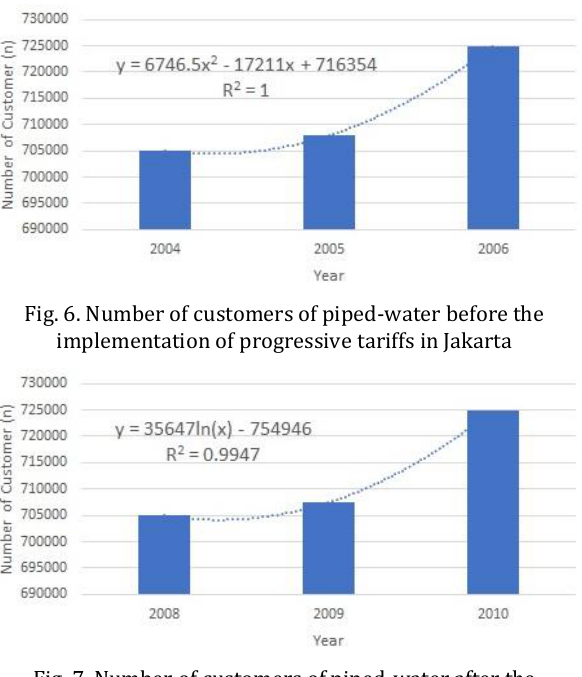
Fig. 7. Number of customers of piped-water after the implementation of progressive tariffs in